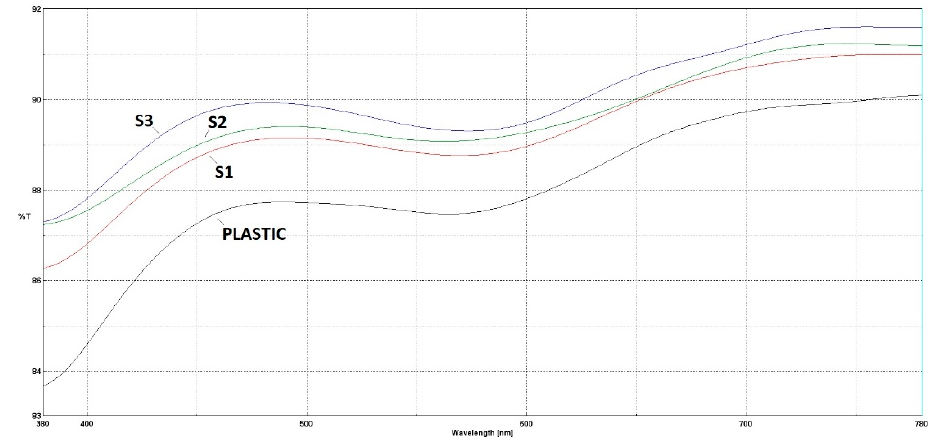
Figure 1. Transmittance spectra of coatings covered with sol-gel silica materials modified